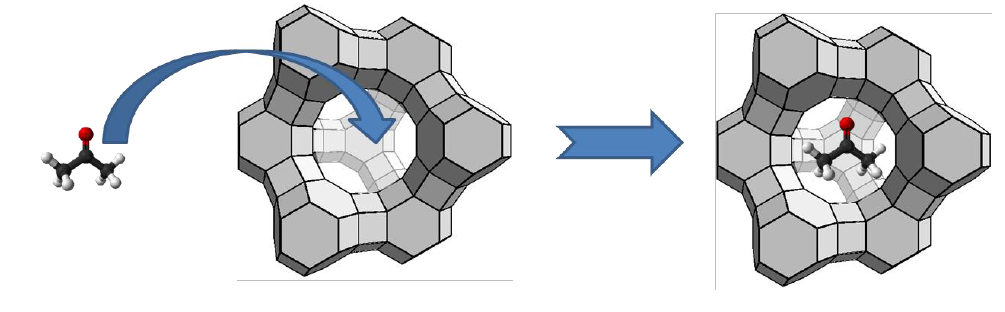
Figure 2. Adsorption of an acetone molecule into a zeolite Y supercage (window 7.4 Å, cage 13.2